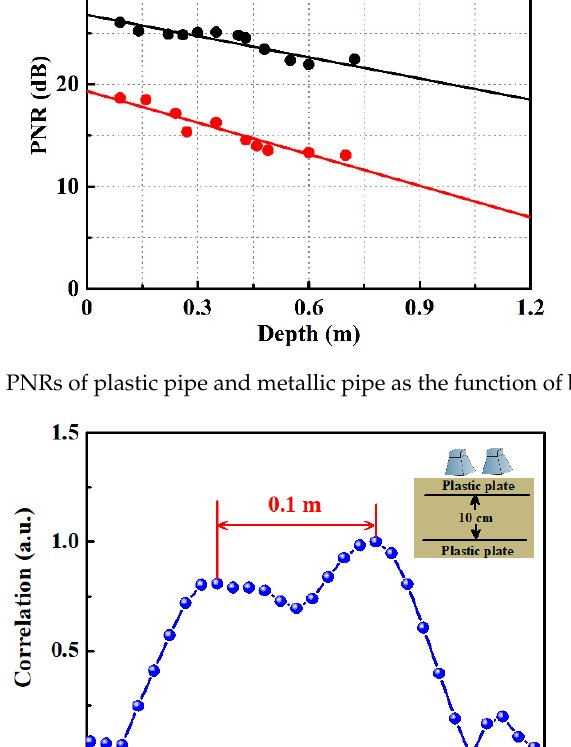
Figure 7. The PNRs of plastic pipe and metallic pipe as the function of buried depth.